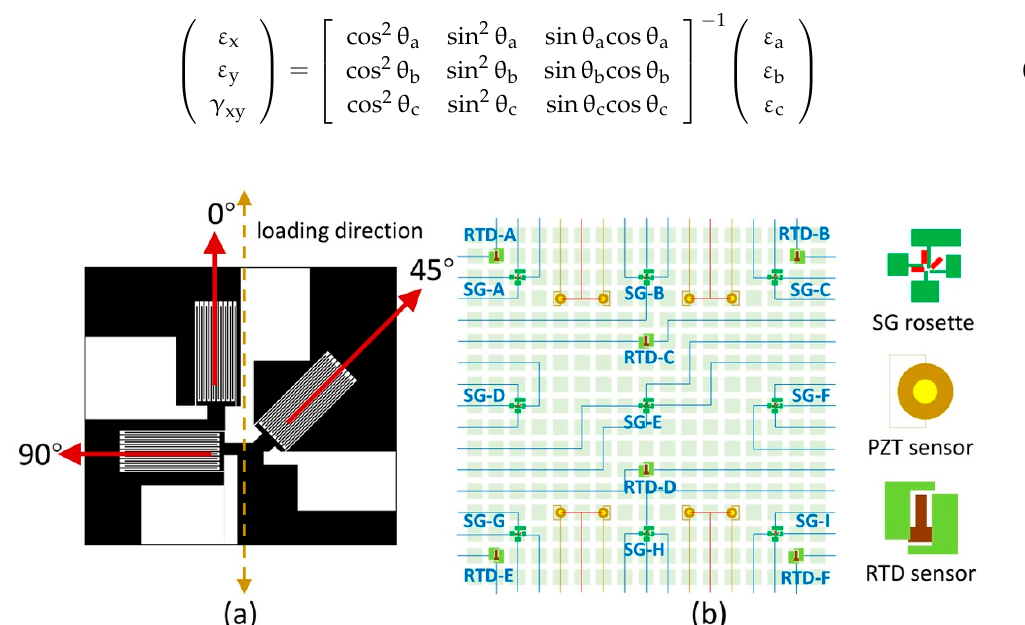
Figure 3. ( a ) Sensor node design of strain gauge rosette in 0°, 45°, 90°; ( b ) Sensor layout and wiring diagram of a 17 × 17 network with 9 strain gauge (SG) rosettes, 8 piezoelectric transducers (PZT) and 6 resistance temperature detectors (RTD) distributed centrosymmetrically.